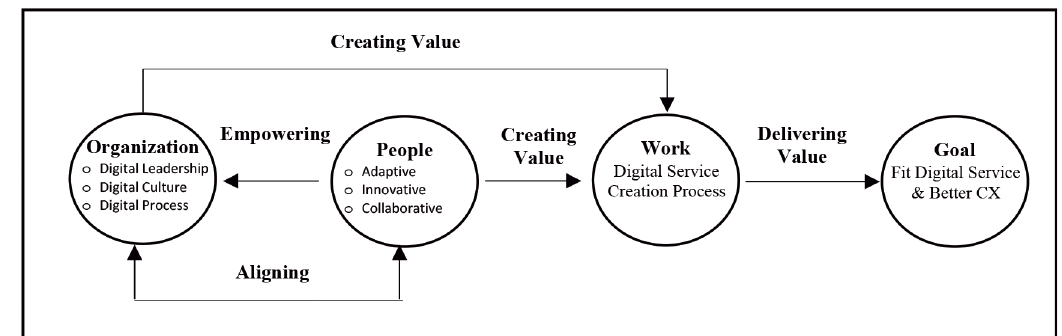
Figure 10. Alignment on Digital Services Creation